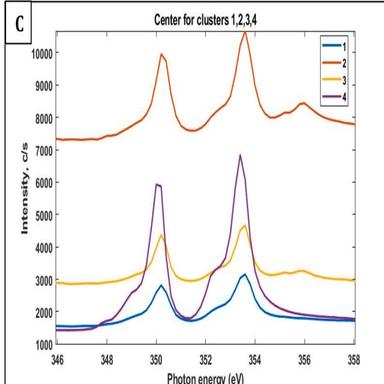
Fuzzy C-Means (FCM) clustering analysis of the NMI region at ambient temperature. Clusters 1 through 4 are visualized in panels A to E, respectively, with the membership probabilities indicated by the color scale. Panel C presents the centroid spectra for each cluster, with lines corresponding to the cluster numbers shown in panels A, B, D, and E.